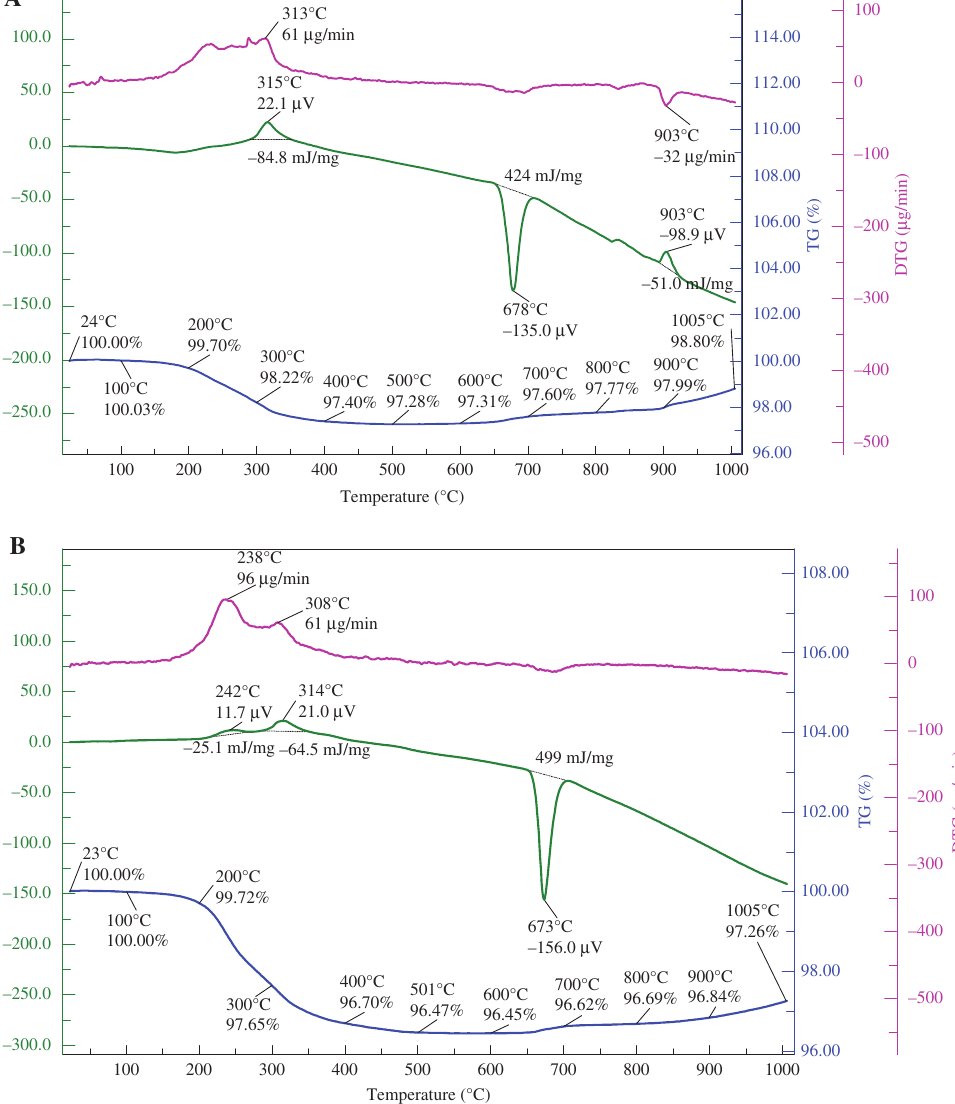
Figure 5: Thermogravimetric analysis (TG), derivative thermogravimetric analysis (DTG) and differential thermal analysis (DTA) curves for (A) 5 wt% hybrid composite, (B) 10 wt% hybrid composite, (C) 15 wt% hybrid composite and (D) 20 wt% hybrid